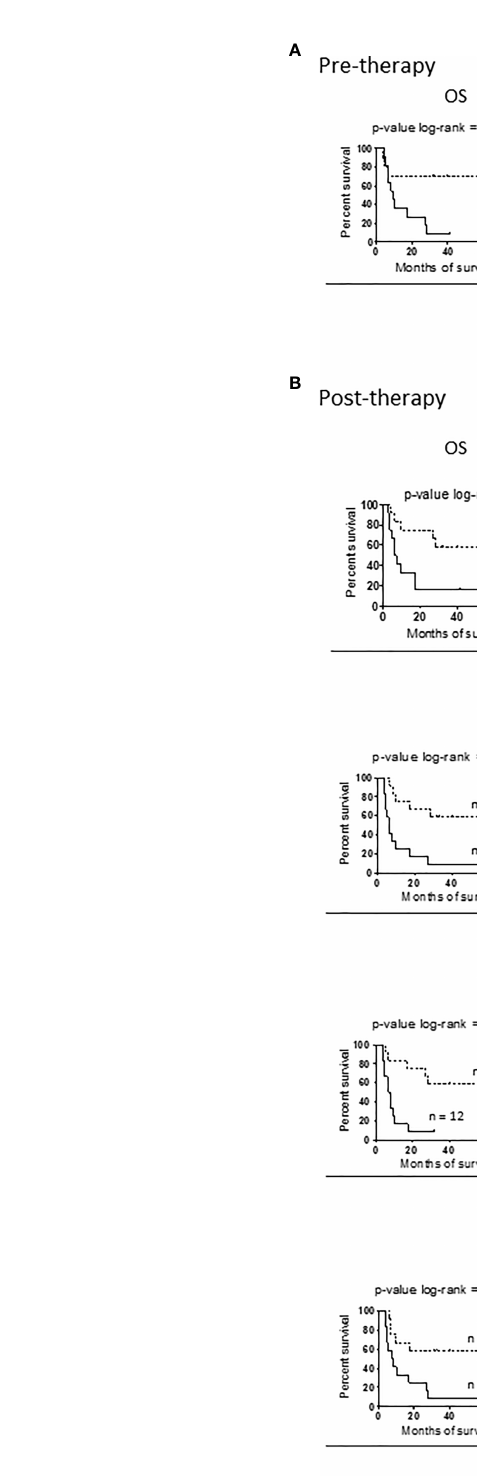
FIGURE 3 | Variables correlating with survival in Nivolumab-treated stage IV melanoma patients. (A, B) Kaplan-Meier curves for OS (right panels) and PFS (left panels) in short survival (solid lines) and long survival (dotted lines) stage IV melanoma patients before therapy (A) and after two months of Nivolumab treatment (B) . Data from 24 patients were used. For each variable, the median value calculated on the entire cohort was chosen as cut-off and reported on the right of the related panels. Log-rank test was used to compare curves. p-values are reported on the top of each